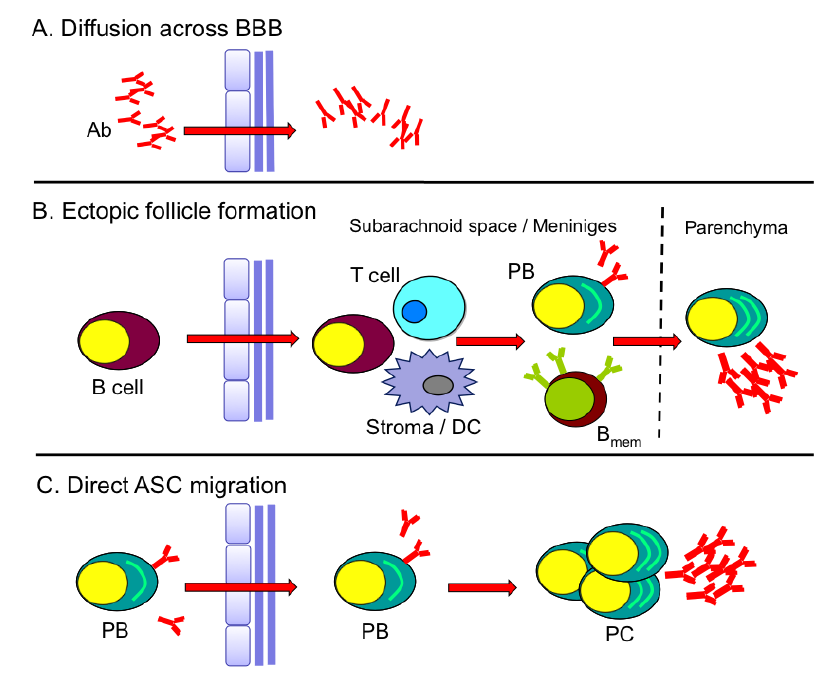
Figure 2. Models for sustained humoral response in CNS. ( A ) Direct penetration of serum Ab into the CNS when blood–brain barrier (BBB) integrity is compromised. ( B ) Formation of ectopic follicle-like structures (B cells, T cells, stroma/dendritic cells (DC)) within the subarachnoid space or meninges giving rise to plasma blast (PB) and memory B cells (B ). ( C ) Migration of peripherally activated PB into the CNS that mem further differentiate into plasma cells